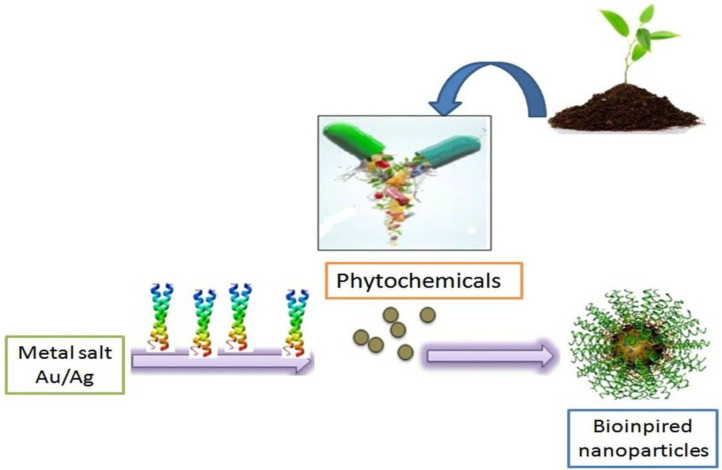
Green synthesis of Cds nanoparticles by bacteria.